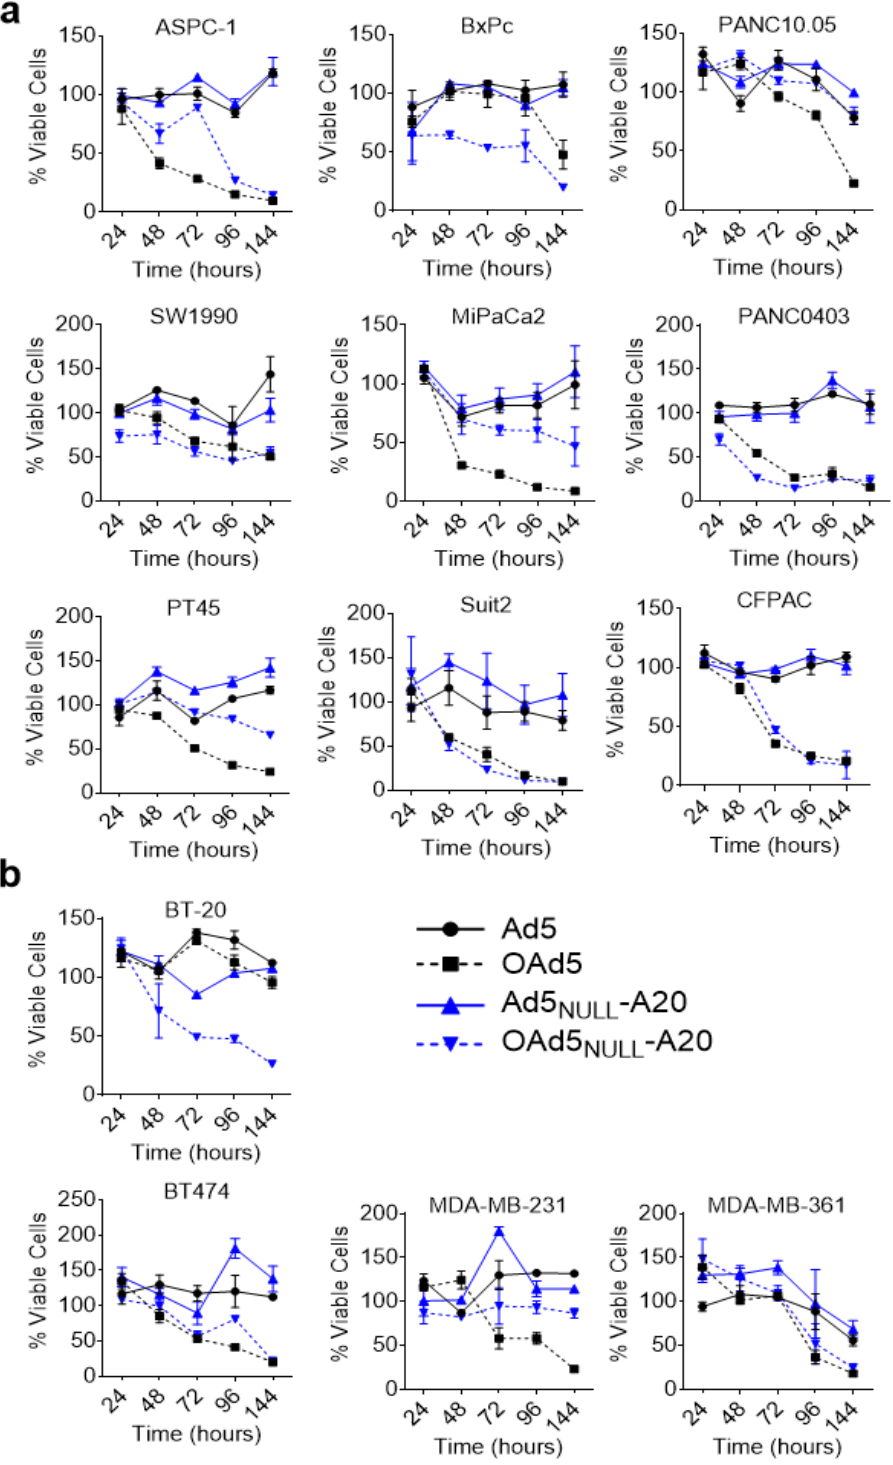
Figure 3. Oncolytic activity of Ad5 and Ad5 NULL -A20 in pancreatic and breast cancer cell lines: Pancreatic cell lines ( a ) and breast cancer cell lines ( b ) were transduced with 5000 vp/cell of either oncolytic Ad5 (black squares), oncolytic Ad5 NULL -A20 (blue triangle upside down), replication deficient Ad5 vector (black circle), or replication deficient Ad5 NULL -A20 vector (blue triangle). Cell viability was quantified 48 h post infection using MTS assay. Error bars represent standard deviation of n = 4.